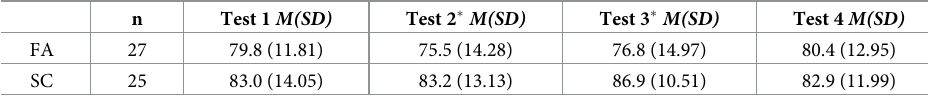
Table 3. Test grades by